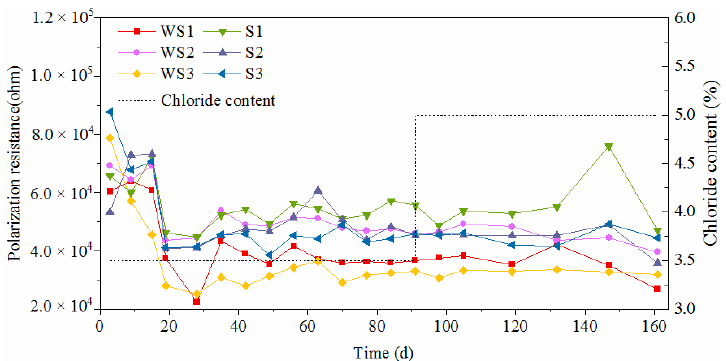
Figure 13. Polarization resistance of novel type-2205 duplex stainless steel.